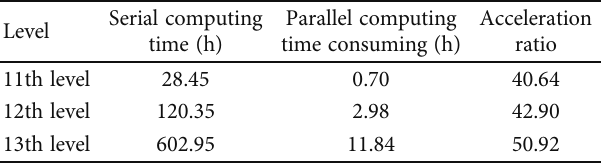
Table 10: Calculation time for di ff erent resolutions. Table 11: Numerical characteristics of the global marine gravity